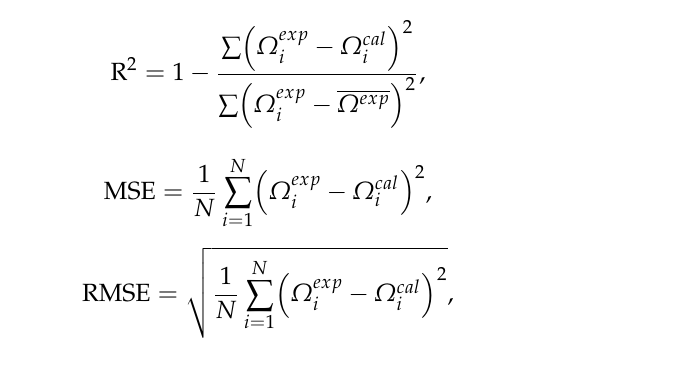
Figure 11. Comparisons of measured and calculated time-domain water surface elevations at the WAR.